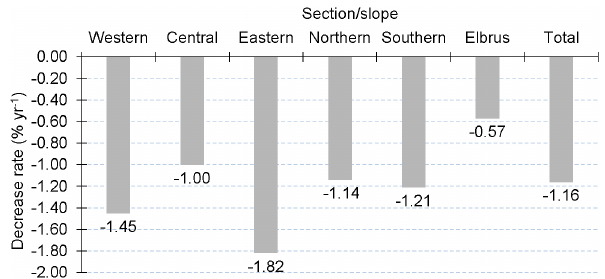
Figure 8. Greater Caucasus glacier area decrease by section and slope in